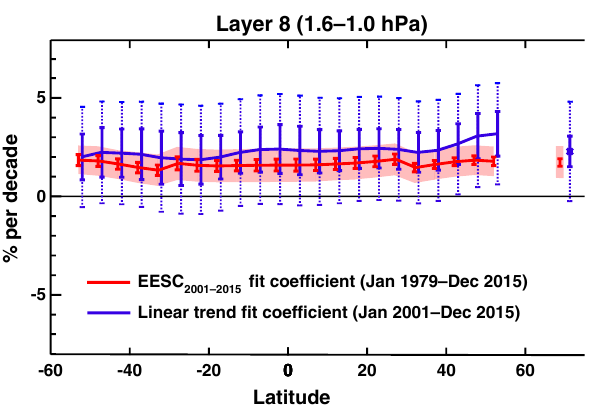
Figure 8. Trend versus latitude for layer 8 (1.6–1.0hPa) from 2001 to 2015 obtained by two methods. Red line and shading were ob- tained by fitting to EESC over the entire time period of 1979 to 2015 and converting to the slope of the EESC curve from 2001 to 2015. Solid vertical lines indicate 2 σ uncertainty due to data variability. Red shading indicates uncertainty including the impact of merging uncertainty. Blue line shows the trend obtained by fitting the data from 2001 to 2015 by a linear trend. Solid vertical bars are the 2 σ uncertainty due to data variability, while larger dashed vertical bars indicate the addition of merging uncertainty. The points on the far right side are the values obtained for the 50 ◦ S–50 ◦ N average. Table 1. 2 σ uncertainty associated with EESC and linear trend proxy terms based on the standard deviation of fits to 10000 Monte Carlo simulations. The total uncertainty is the root mean square of these values and the statistical uncertainty derived from the good- ness of the regression model